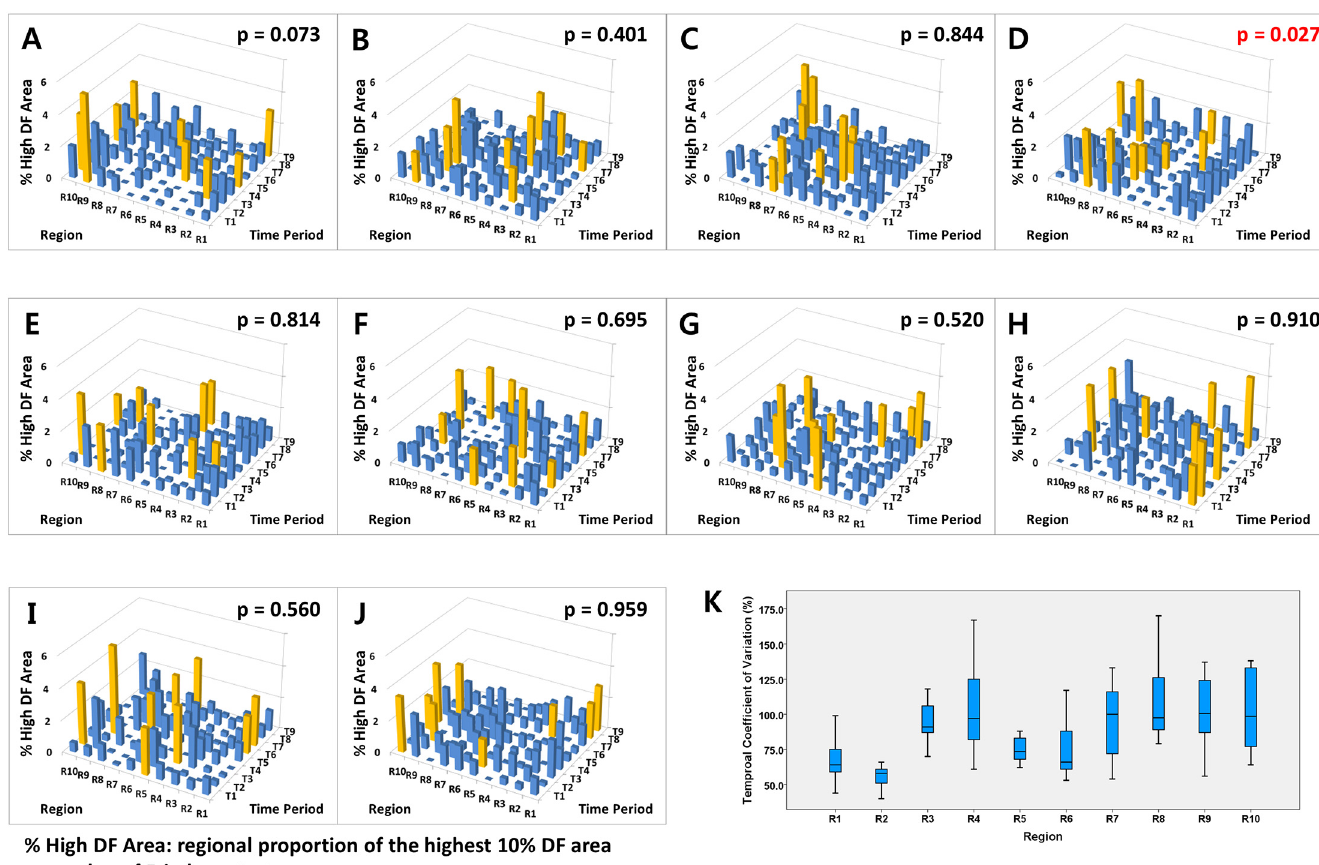
Fig 4. A-J. Variance of regional proportions of the high DF area (% High DF Area) in the ten LA sections (R1 – R10) during the nine DF analysis periods (T1 – T9) among ten patients. Yellow bars represent the highest % High DF Area among the ten LA sections. The % High DF Area represents the regional proportion of the highest 10% DF area (the highest 10% DF area / area of each LA section). R7 – R10 represents the four pulmonary veins. The high DF area was consistently located in the pulmonary vein area in each patient (Panel 4D). K. The coefficients of variation from the overall analysis of the periods (T1 – T9) in each region for all patients.